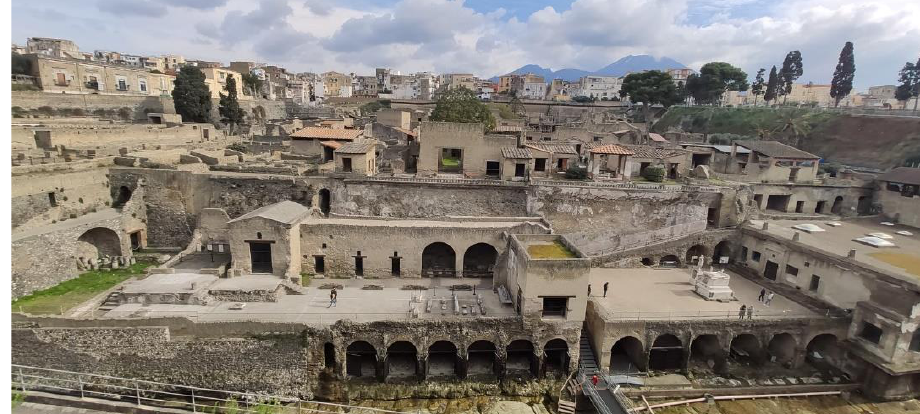
Figure 1. View of Herculaneum Archaeological Park with actual city and Vesuvius volcano in the back [31].